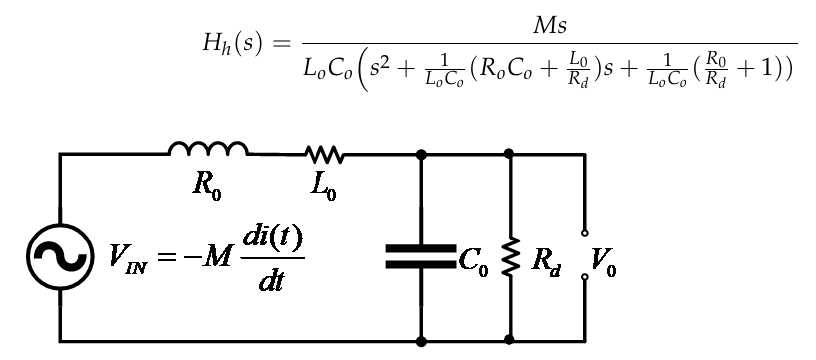
Figure 6. Lumped parameter model of the Rogowski coil .